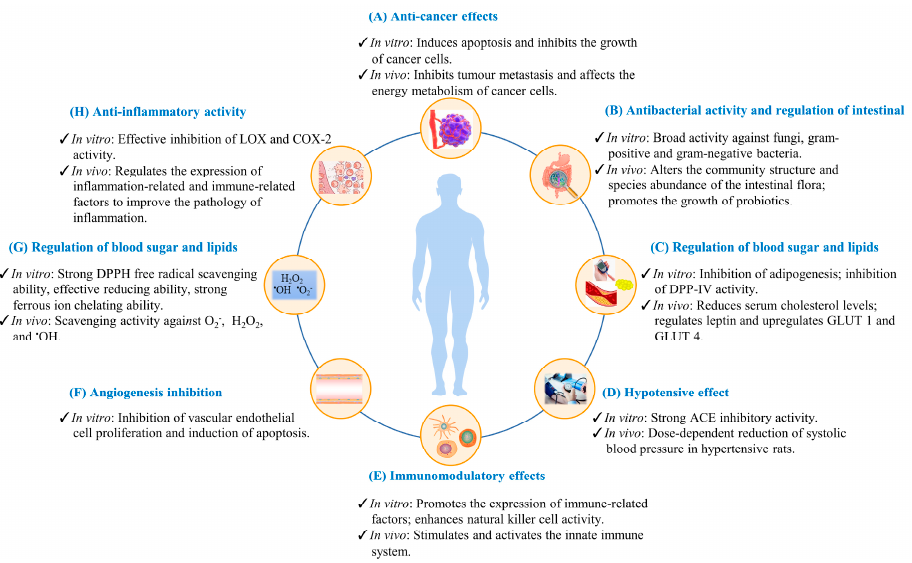
Table 6. Biological functions of insect active ingredients.